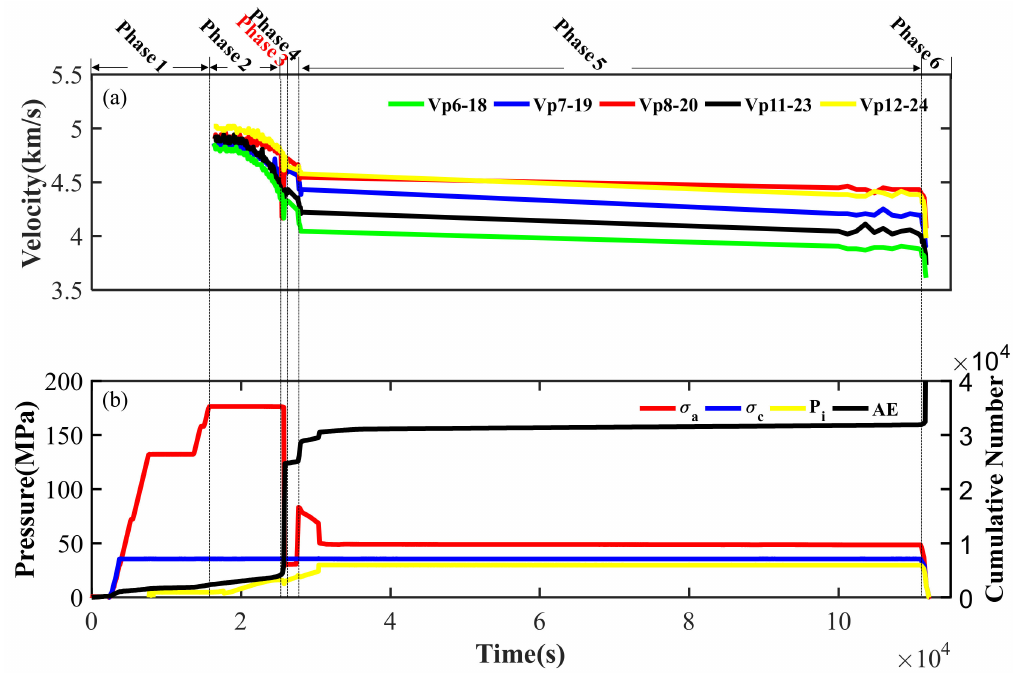
Figure 5. ( a ) P-velocities measured along horizontal paths as indicated in Figure 3; ( b ) the procedure of the hydraulic fracturing experiment: the axial compression ( σ a ), confining pressure ( σ c ), inlet fluid pressure (P i ), and cumulative number of AE events versus time. The whole procedure could be divided into six phases according to different stress loading.